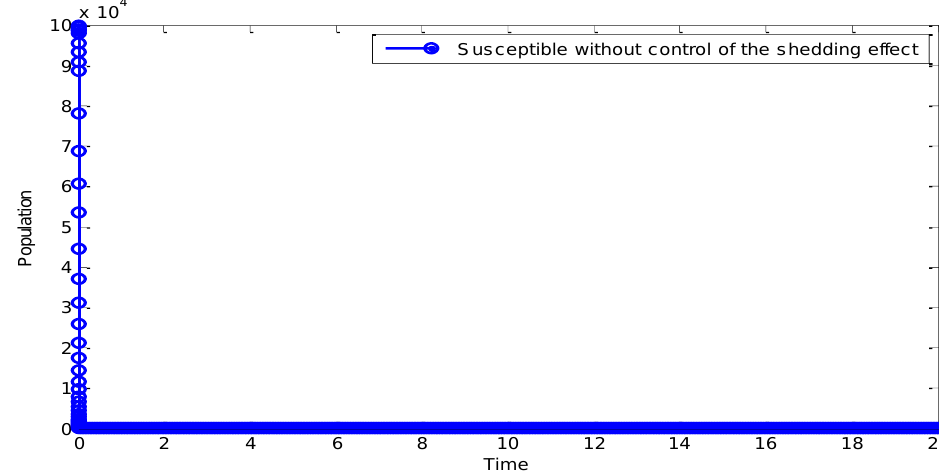
Figure 2. Dynamics of susceptible population without control.